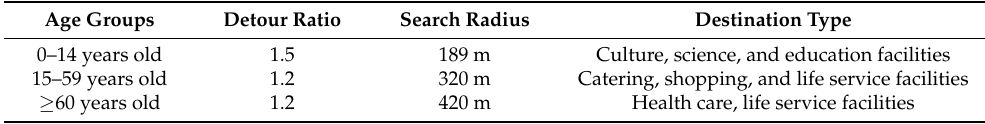
Table 3. UNA simulation parameters and destination settings of different age